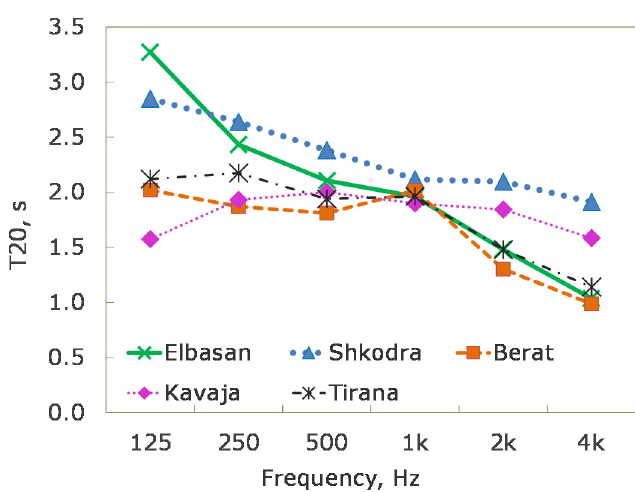
Figure 15. Measured results of early decay time (EDT).